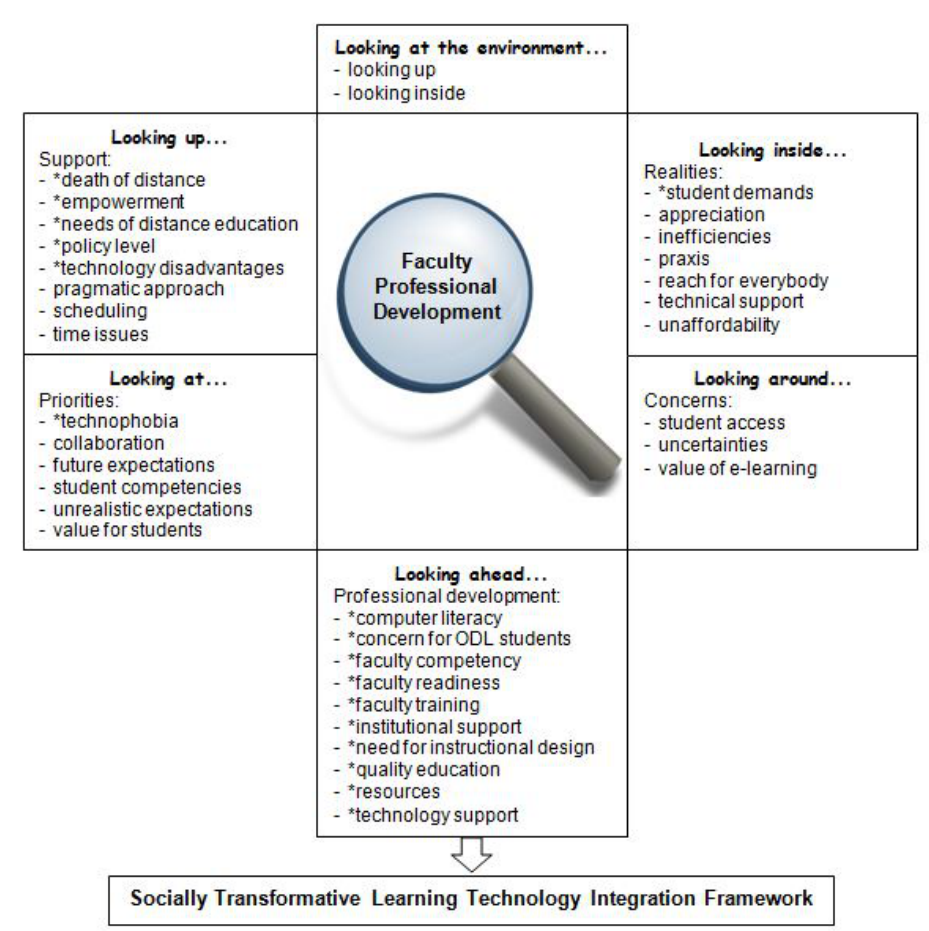
Figure 3 . Model for faculty development towards socially transformative learning technology integration for open distance learning (* significant difference p ≤